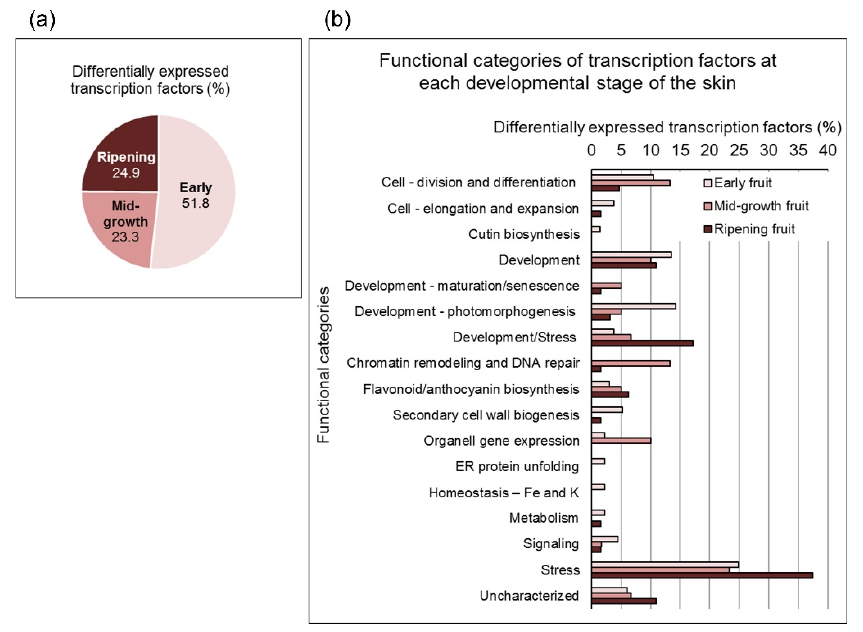
Figure 2. Graphical representation of the percentage of differentially expressed transcription factors in pomegranate skin ( a ) at the three developmental stages, ( b ) categorized into functional groups. The transcript function was determined manually based on the respective Arabidopsis orthologs at https://www.arabidopsis.org/.